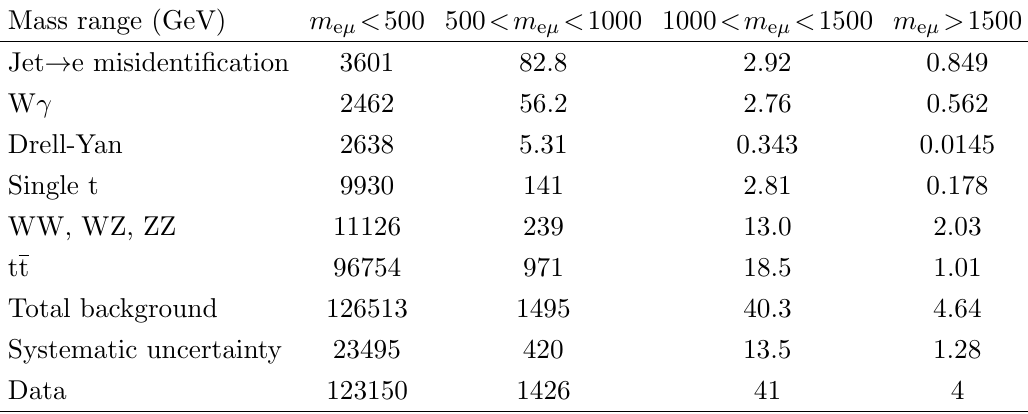
Table 1 . Numbers of events for background processes, total background with its associated sys- tematic uncertainties, and data, in four bins of e (cid:22) invariant mass.